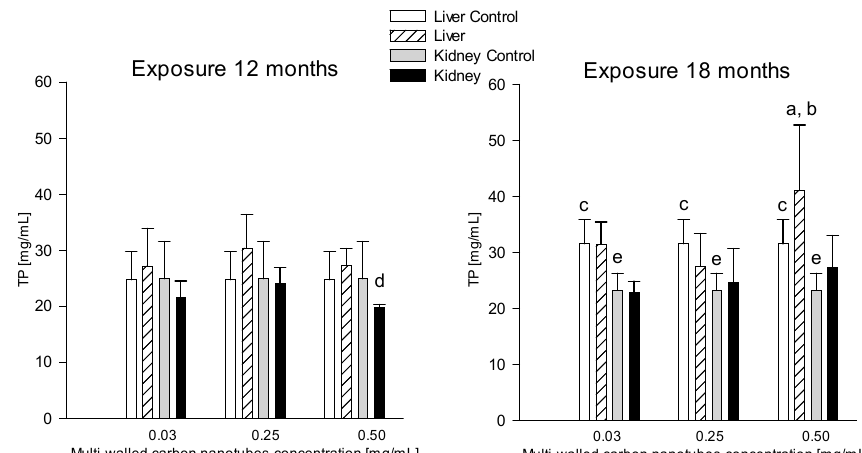
Figure 4. Comparison of total protein (TP) concentrations in the liver and kidneys of animals exposed to multi-walled carbon nanotubes for 12 and 18 months. (a)—statistically significant difference for the group receiving MWCNTs in concentration of 0.5 mg/mL versus 0.25 mg/mL in the livers ( p = 0.022493); (b)—statistically significant difference for the group receiving MWCNTs in concentration of 0.5 mg/mL at 18 months versus 12 months in the livers ( p = 0.032701); (c)—statistically significant difference for control group at 18 months versus control at 12 months in the livers ( p = 0.030844); (d)—statistically significant difference for group receiving MWCNTs in concentration of 0.5 mg/mL versus 0.25 mg/mL in the kidneys ( p = 0.0197); (e)—statistically significant difference for control group at 18 months versus control at 12 months in the kidneys ( p =